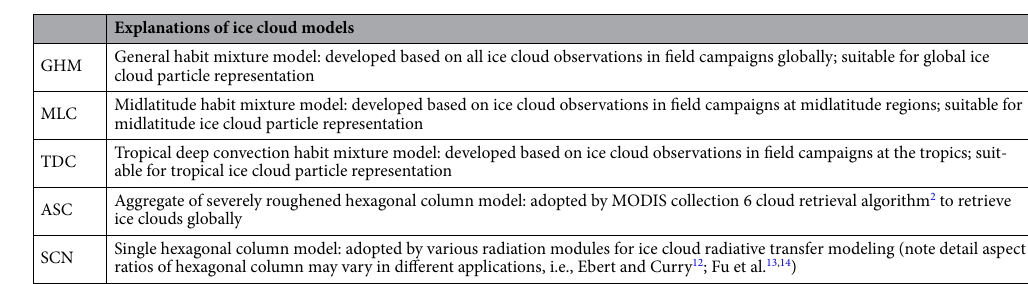
Table 1. Explanations of abbreviations for the five ice cloud